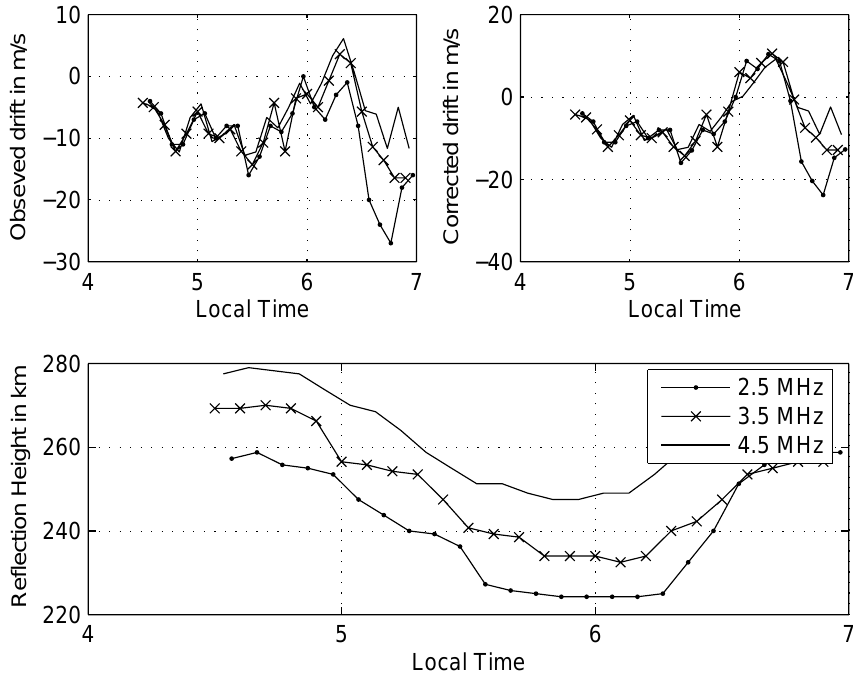
Fig. 2. The observed (top left panel) and corrected (top right panel) multi-frequency vertical velocity profile on 19 March 2004. Variation of the reflection height is shown in the bottom panel. Ground sunrise time –